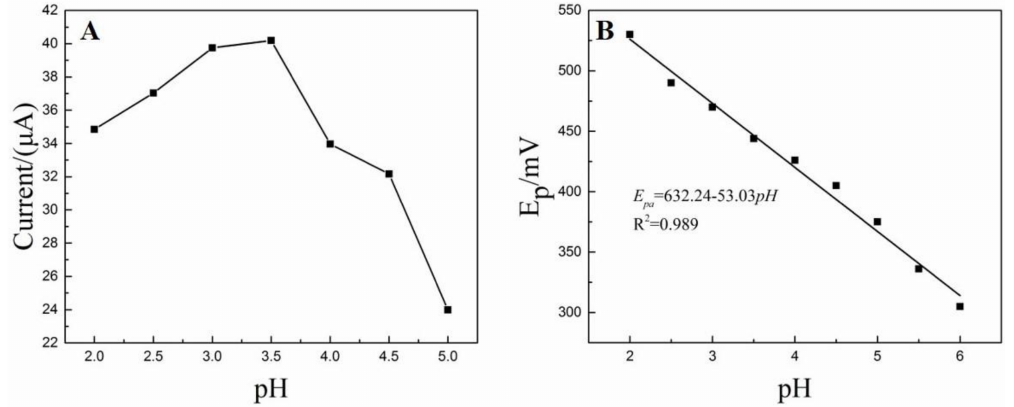
Figure 6. ( A ) The effect of pH on the oxidation peak currents of dopamine (DA); ( B ) Linear relationship between oxidation peak potentials ( E p ) and